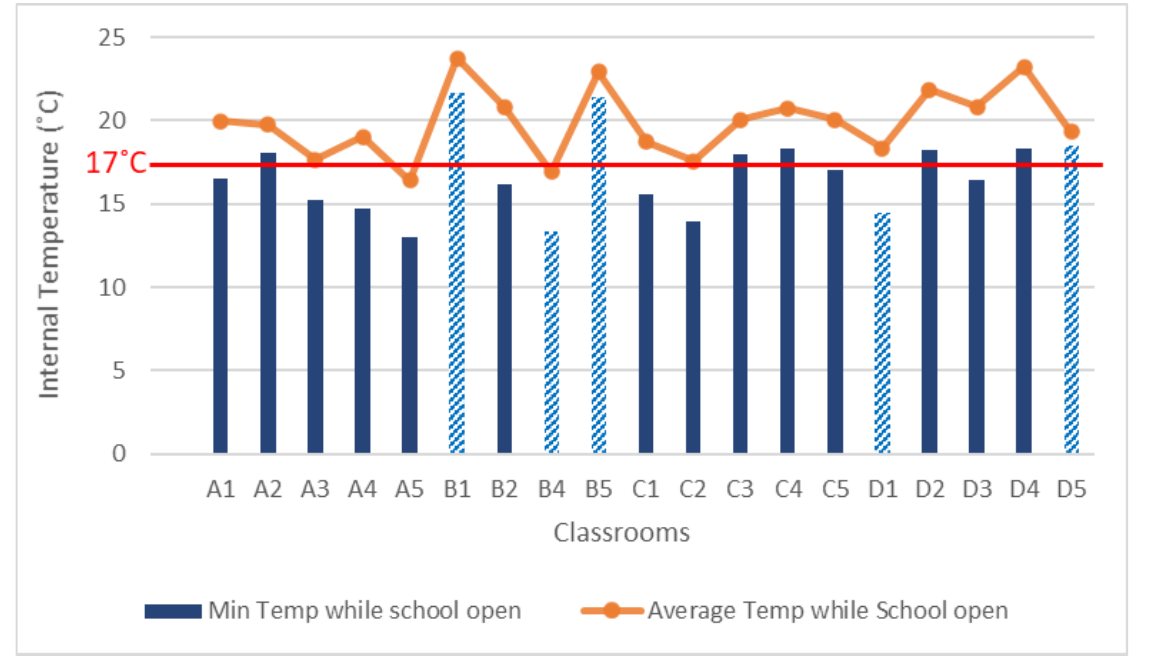
Figure 19. Indoor temperature in the classrooms during school hours, with classrooms B1, B4, B5, D1 and D5 having mechanical ventilation.